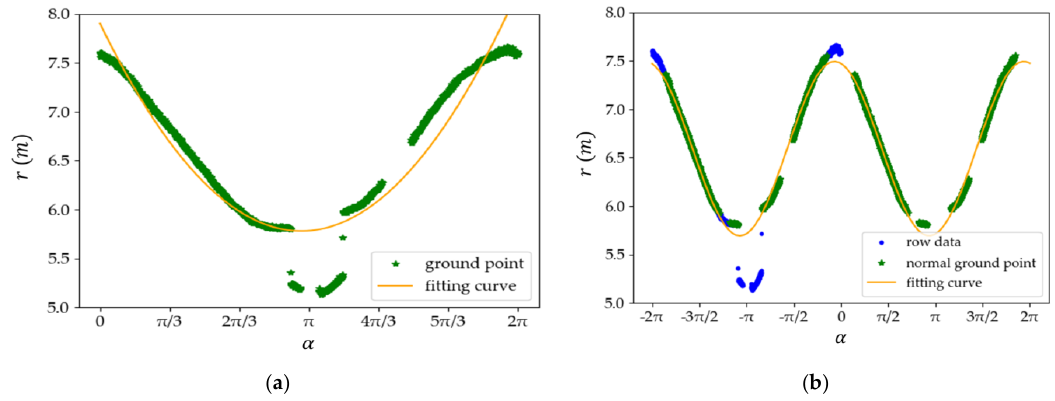
Figure 10. The processes of the fitting curve L1 . ( a ) Fitting the L0 curve in step 1; ( b ) Fitting the final L1 curve in step 3. curve in step